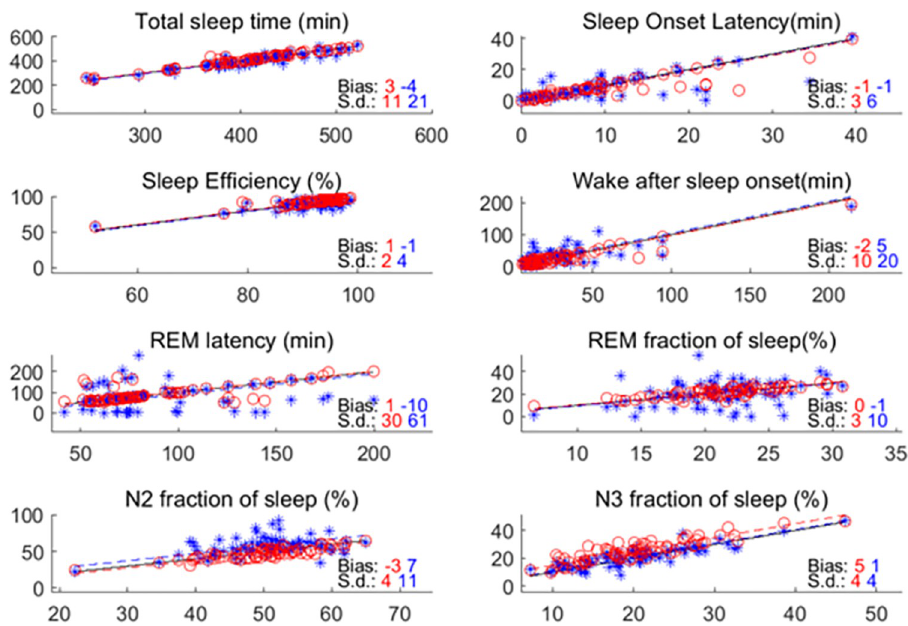
Fig 5. Eight panels, one for each sleep metric. The x-axis is the value for scorer1. The y-axis is the alternative score, which is either scorer2 or automatic sleep scoring. The red color indicates comparison between scorer1 and scorer2 (o). The blue color indicates comparison between scorer1 and automatic sleep scoring ( � ). ‘s.d.’ refers to the standard deviation of the differences between S1 and the alternative scoring. ‘Bias’ refers to the average difference.’ Solid line is the identity. Dashed line is the